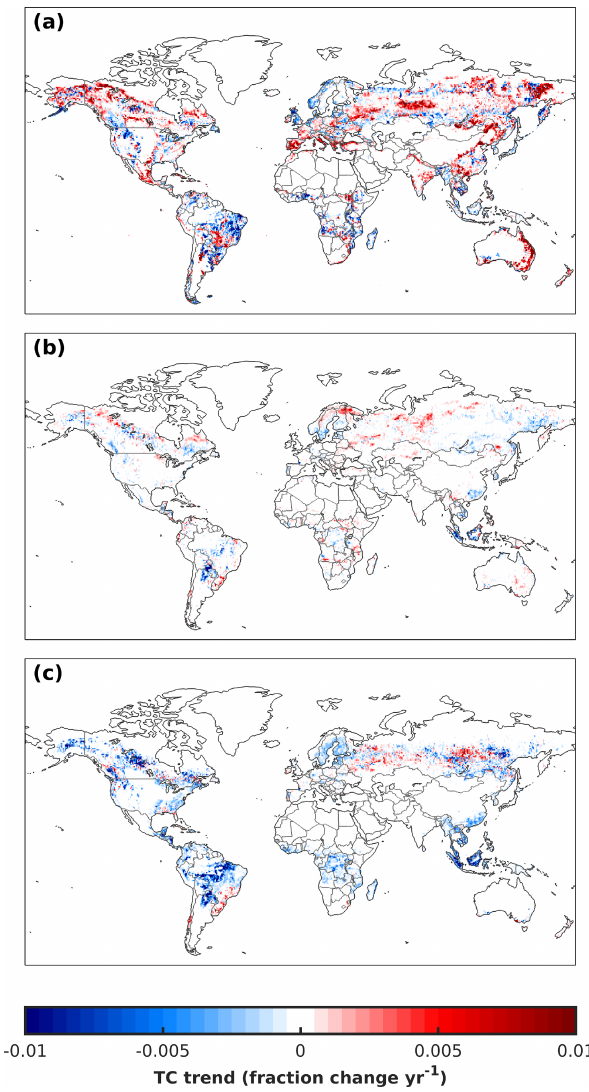
Figure 3. Spatial distribution of the linear net trend (change in cover fraction per year) in TC for 2001–2016 in the (a) MODIS, (b) ESA, and (c) GFWMOD datasets. The fraction change per year is calculated by dividing the TC trends in each grid cell (expressed in km 2 yr − 1 ) by the corresponding grid